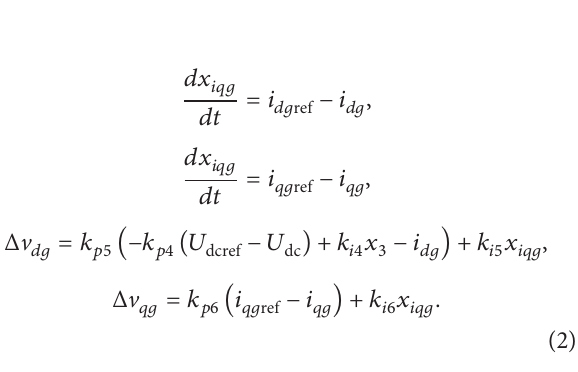
Figure 4: Control block diagram of the wind farm side